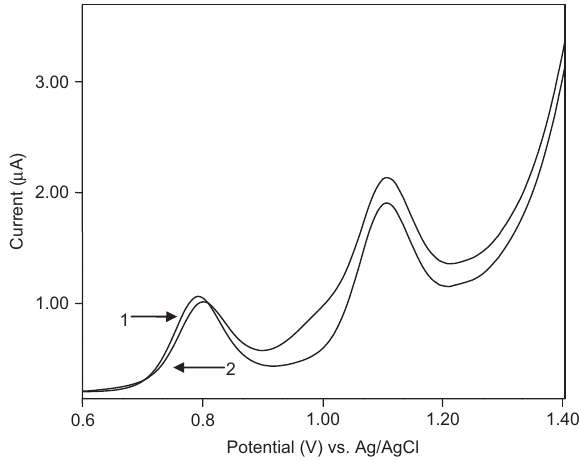
Figure 12 Curve (1) differential pulse voltammogram (DPV) of 5.3 × 10 -4 m DNA at bare multi-walled carbon nanotube paste elec- trode (MWCNTPE) in 0.2 m acetate buffer (pH 5.0 ± 0.01), curve (2) DPV of 5.3 × 10 -4 m DNA at drug modifi ed MWCNTPE, pulse ampli- tude 50 mV, scan rate 50 mVs -1 , current range 10 μ